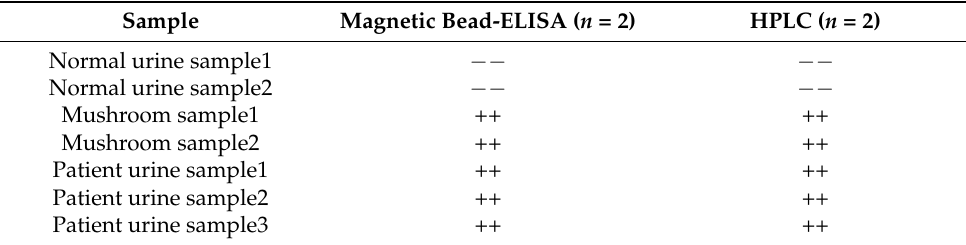
Table 4. Comparison of two detection